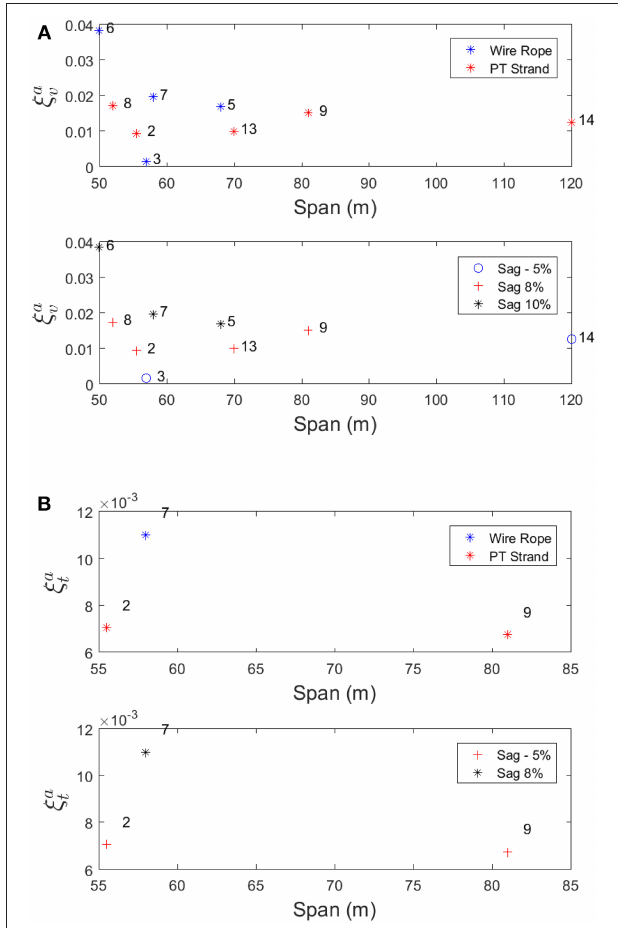
FIGURE 16 | Vertical (A) and torsional (B) anti-symmetric damping ratios of footbridges.